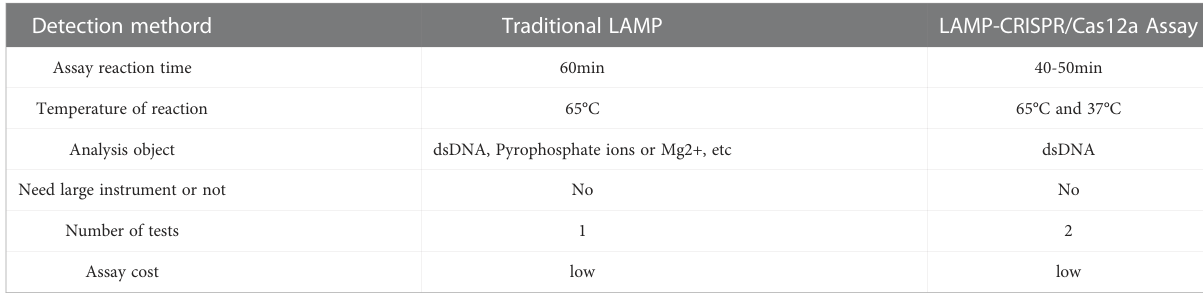
TABLE 2 Comparison of the LAMP-CRISPR/Cas12a Assay with Traditional LAMP for detection of B. xylophilus . Detection